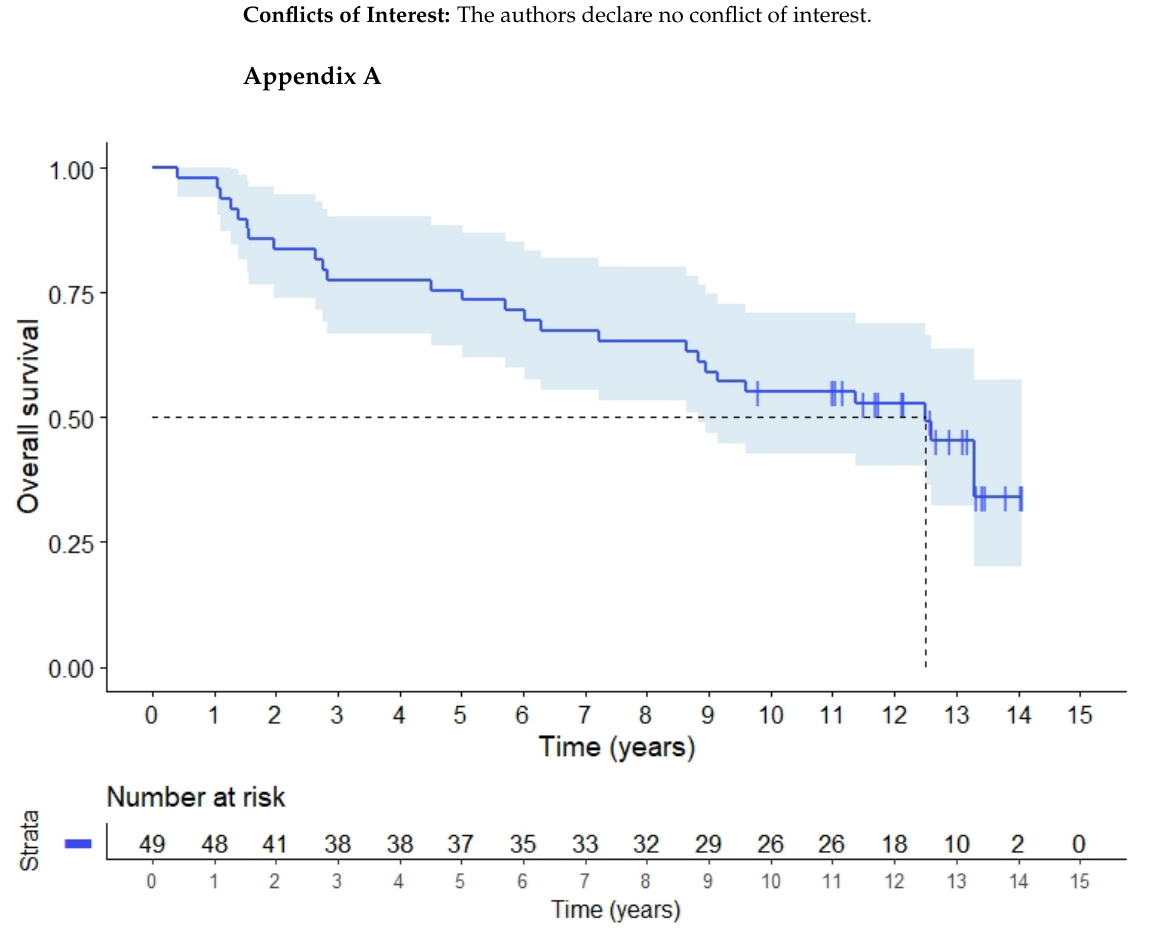
Figure A1. Overall survival for 49 rectal cancer patients, 43 with locally advanced and 6 with recurrent adenocarcinomas.